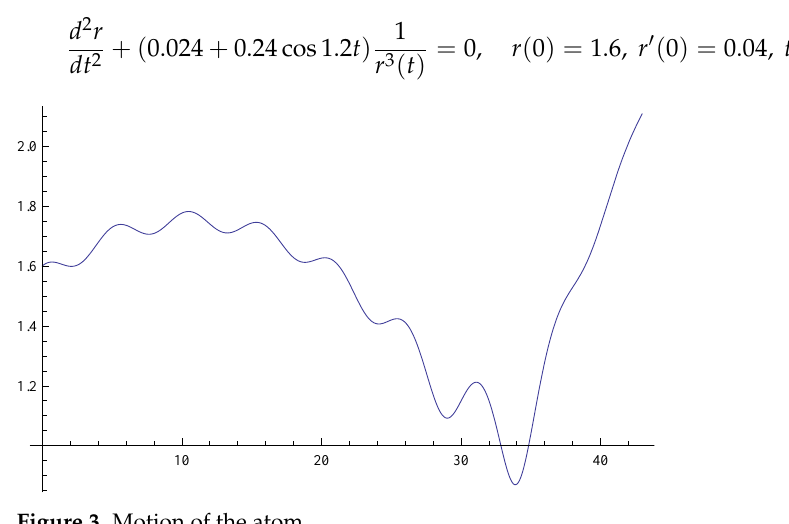
Figure 3. Motion of the